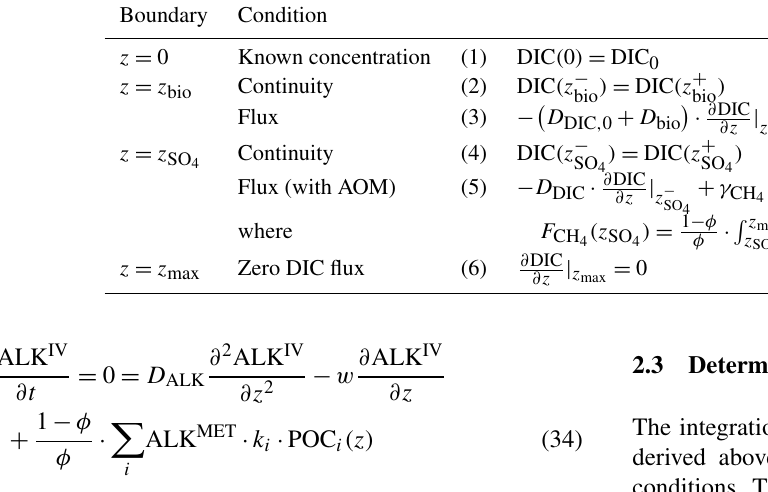
Table 7. Boundary conditions for DIC. For the boundaries we define z − __ = lim h → 0 (z __ − h) and z + __ = lim h → 0 (z __ + h)